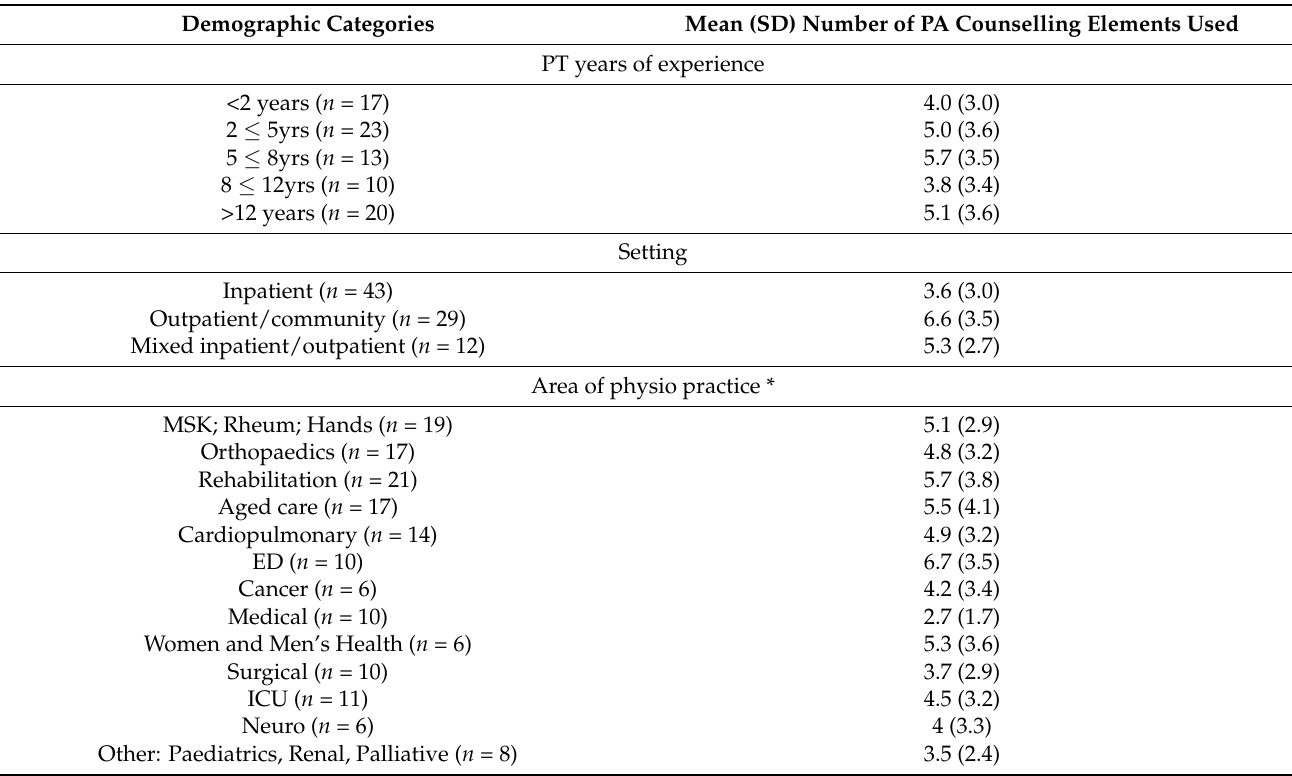
Table 2. The influence of experience and clinical setting on the total number of elements in physiotherapy routine care. Demographic